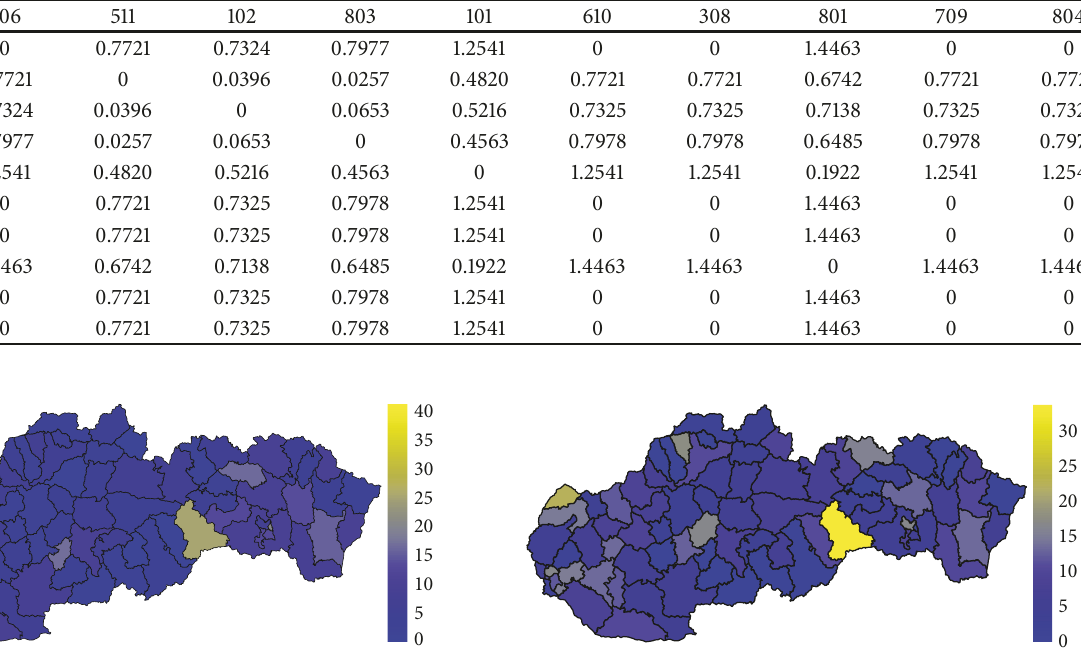
Figure 3: The average annual standardised mortality rate of the female sex in the individual districts of the Slovak Republic for the period from 2013 to 2015.